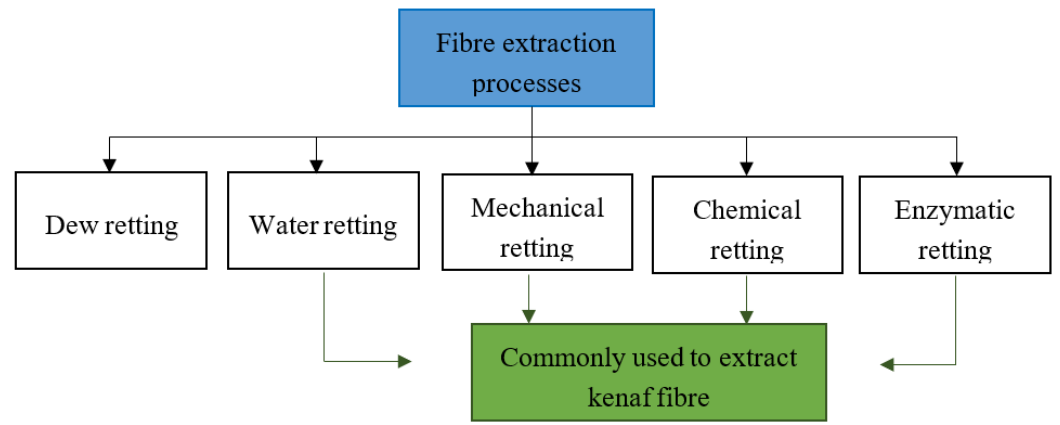
Figure 2. Different retting processes in extracting plant fibre.